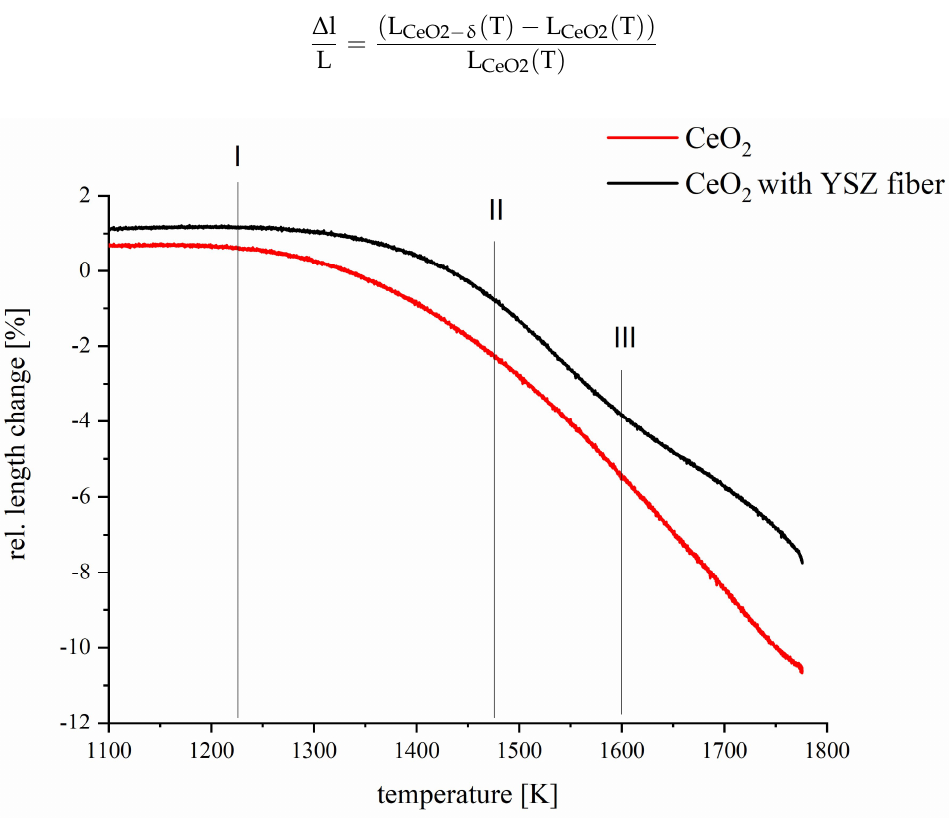
Figure 5. The relative length changes of sample dimension of CeO 2 (red) and CeO 2 with YSZ fiber (black) as function of